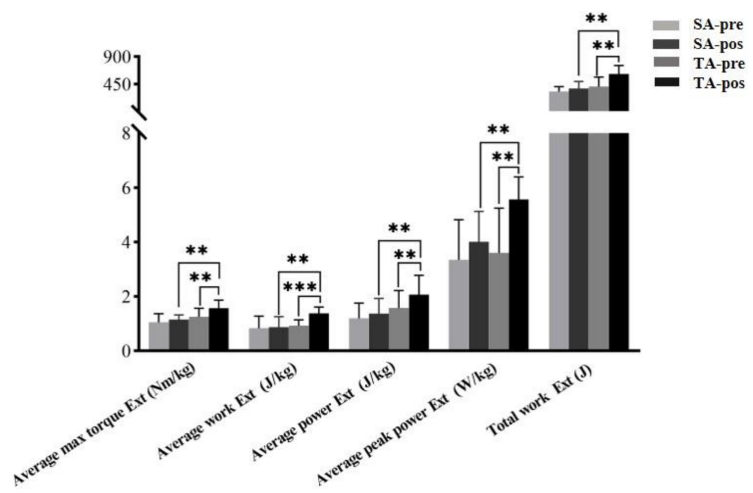
Figure 4. The simple main effects on knee extension (Ext) before and after acupuncture for each isokinetic parameter in the SA group and TA group. True acupuncture group (TA), sham acupuncture group (SA). ** p < 0.01; *** p <